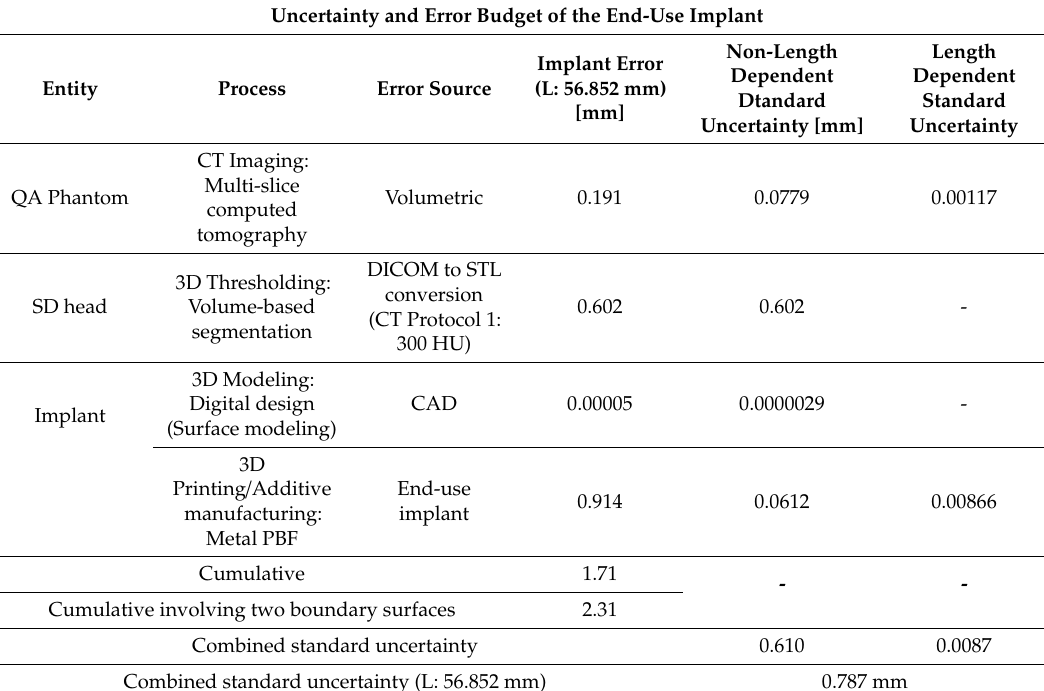
Table 9. The cumulative inaccuracies of the additively manufactured end-use implant.